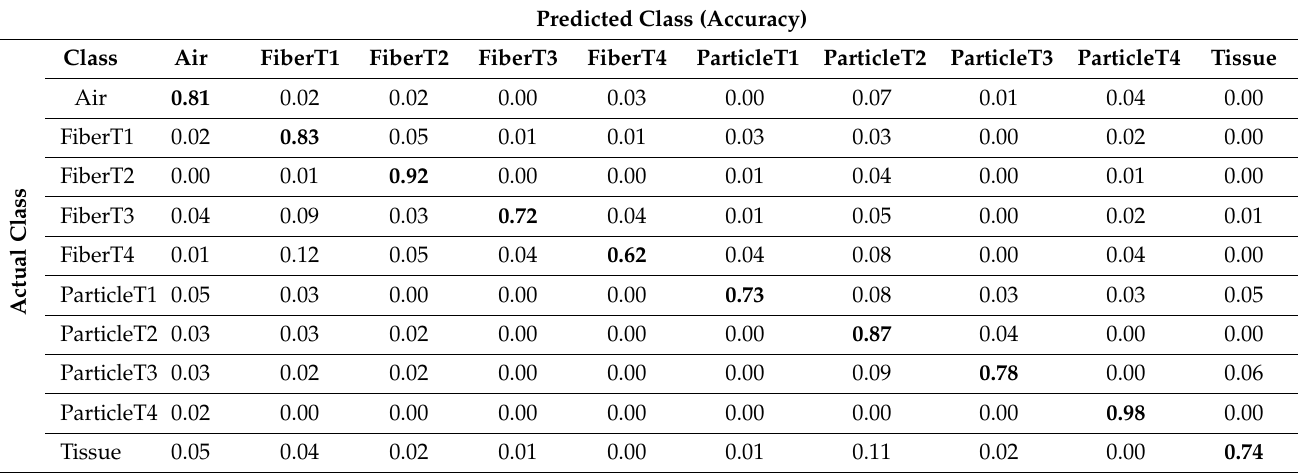
Table 5. Confusion matrix of the MobileNetV2